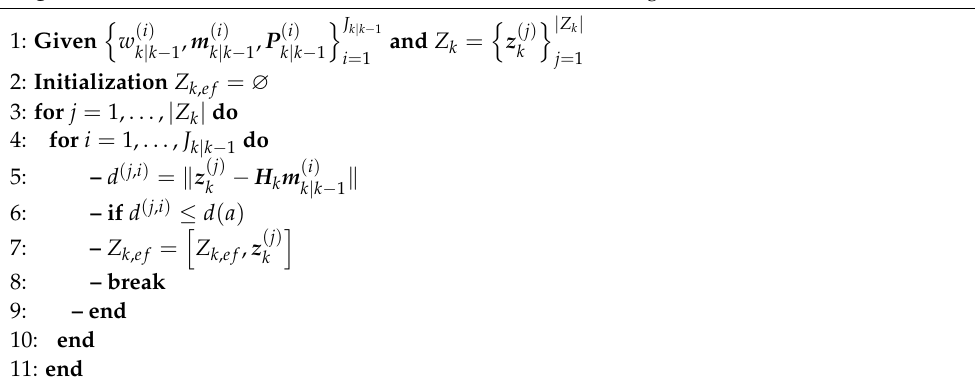
Algorithm 1. The observation selection for the GM-PHD filter